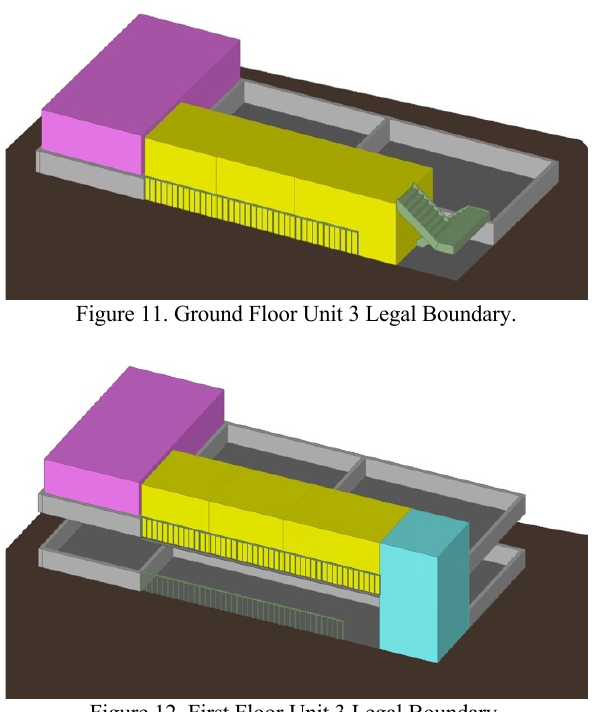
Figure 12. First Floor Unit 3 Legal